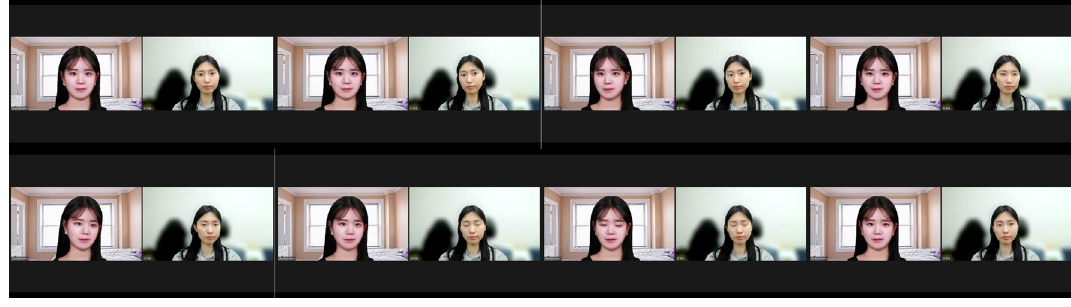
Figure 10. Demonstrated videos in